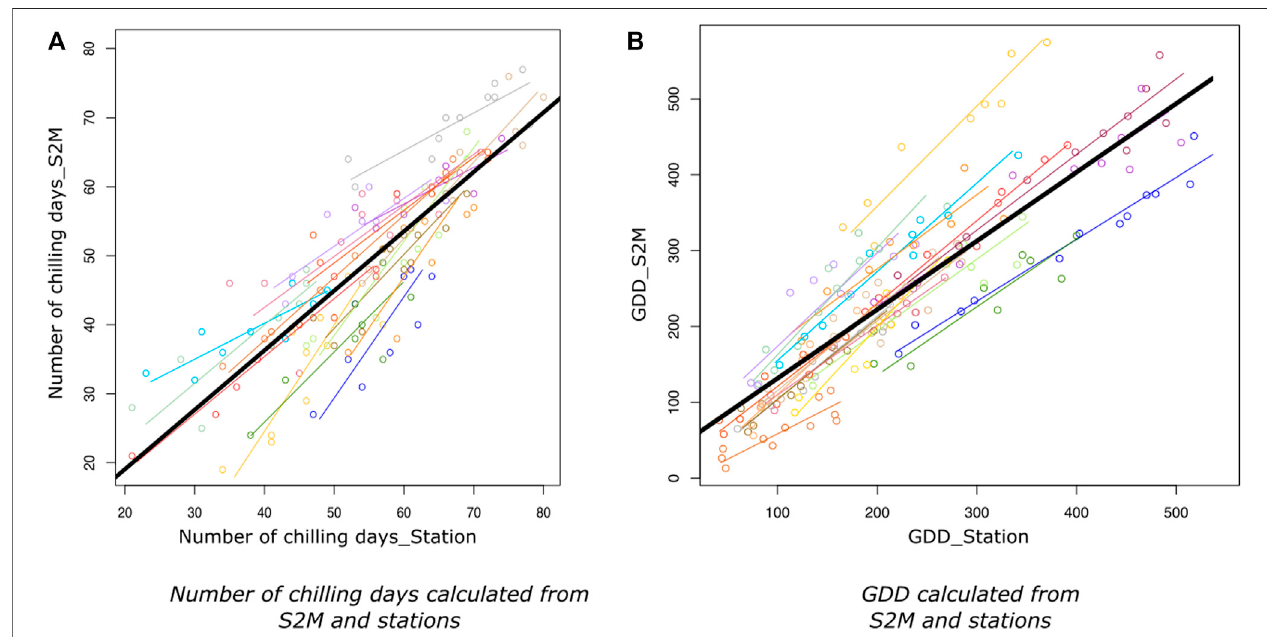
FIGURE 4 | Relationship between number of chilling days (A) and growing degree days (B) calculated from S2M and from stations, with stations having at least 8 years with accurate data. Lines represent the linear regressions of the number of chilling days or GDD calculated from S2M as a function of chilling days or GDD calculated from stations, for each station. Colors represent stations. The black line corresponds to the linear model taking all stations together.